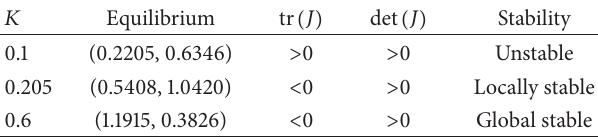
Table 1: The condition for three positive equilibria exists in system. 𝐾